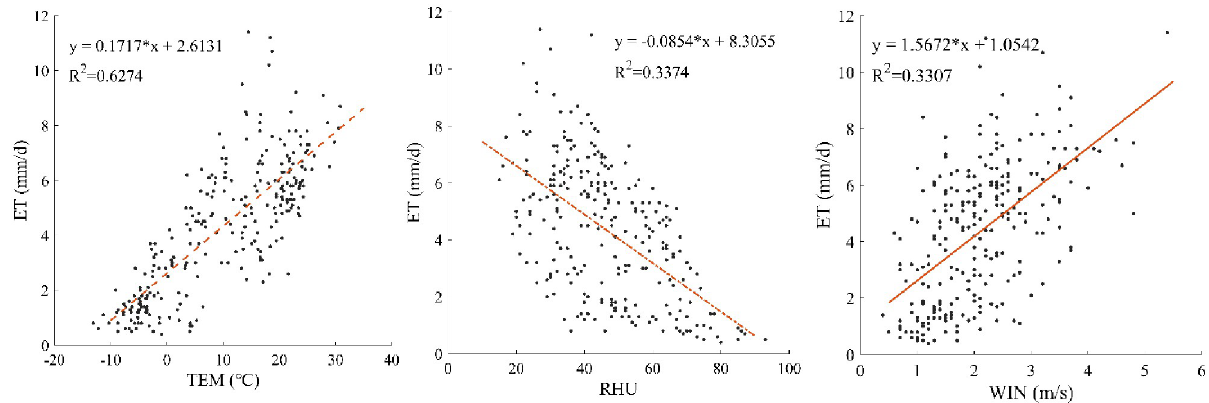
Fig 4. The linear relationship between evapotranspiration and meteorological